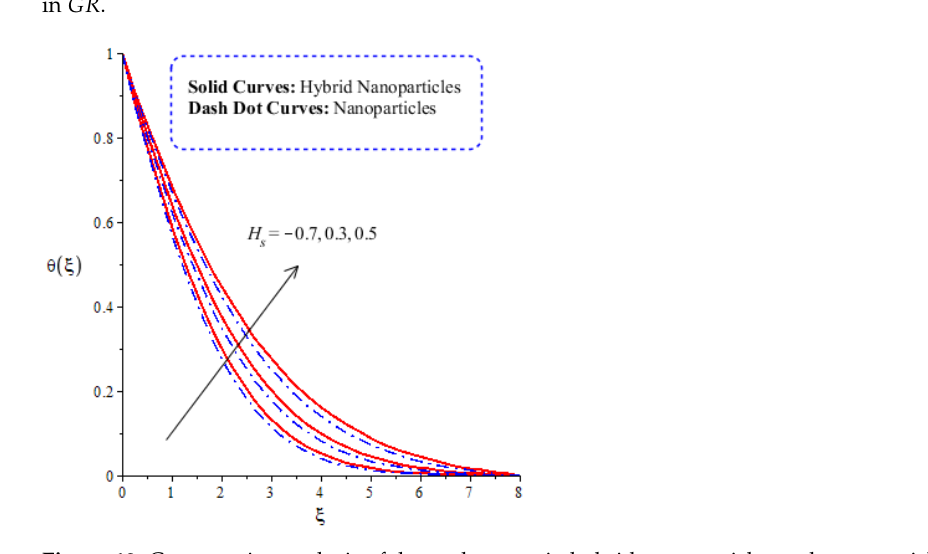
Figure 10. Comparative analysis of thermal energy in hybrid nanoparticles and nanoparticles versus change in H s .